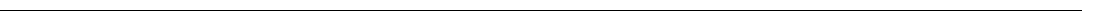
Fig. 2 Routes of mating-type chromosome evolution in Microbotryum . Model for mating-type chromosomal rearrangement events, as inferred from comparisons with the two mating-type chromosomes of M. lagerheimii (used as a proxy for the ancestral mating-type chromosomes in the genus 16 ). Mating-type chromosome content across Microbotryum species is illustrated by colors referring to different parts of the two M. lagerheimii mating-type chromosomes (Supplementary Figs. 5 – 8). The inferred ancestral locations of putative centromeres and mating-type loci are indicated in yellow and black, respectively, and the regions of suppressed recombination are dashed. Chromosome sizes are indicated by their relative scales; the last stage in the evolution of recombination suppression often involves increases in chromosome size due to the accumulation of repetitive elements. Mating-type chromosome evolution in a M. lychnidis-dioicae , b M. silenes-acaulis , c M. violaceum caroliniana , d M. scabiosae , and e M. v. paradoxa , in which the top edge of the mating-type chromosome corresponds to a rearrangement from the middle of the chromosome, supporting complete recombination suppression up